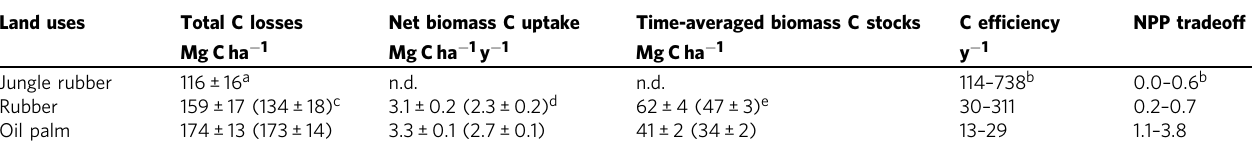
Totalabovegroundandbelowground(downto50cmdepth)Clossesafterrainforestconversiontoplantations.NetbiomassCuptakeandtime-averagedCstocksinbiomassassuminglinearincreaseof biomass over time. Carbon ef fi ciency as unit of C lost (MgCha − 1 ) per unit of yield produced (MgCha − 1 y − 1 ). NPP tradeoff as unit of yield produced (MgCha − 1 y − 1 ) per unit of NPP lost for ecosystem functioning (NPP eco ) a Mean±SE ( n = 8) b Range of replicates c Total biomass time-averaged C stocks (only aboveground